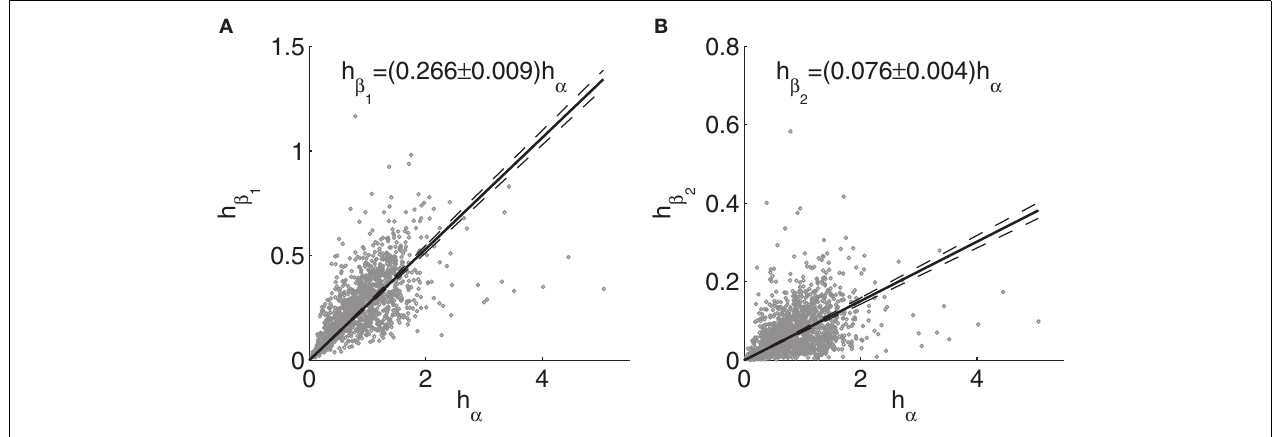
FIGURE 9 | Relationships between peaks heights from fitted model spectra. (A) Beta 1 vs. alpha; (B) Beta 2 vs. alpha. Dashed lines and the text indicate 99% confidence intervals for the